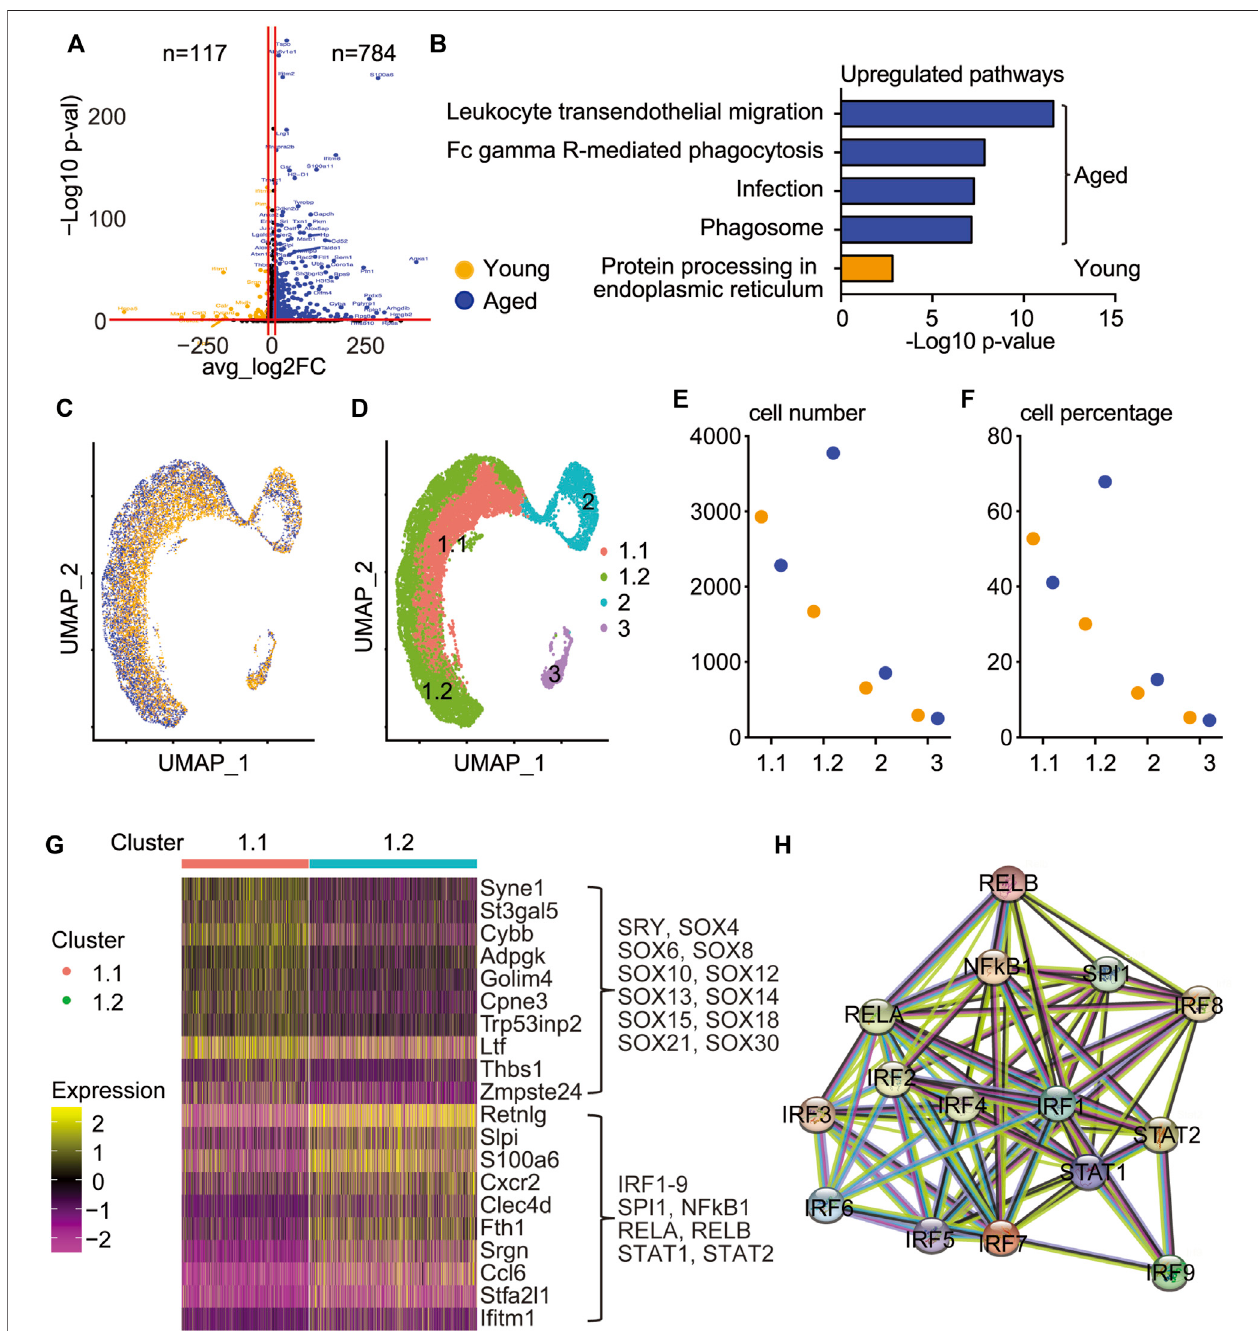
FIGURE 3 | Aged callus SSPCs contain an in fl ammatory osteogenic sub-cluster with upregulated IRF pathway. Bioinformatics analysis of clusters 1 – 3 comparing young and aged SSPCs. (A) Upregulated genes in young and aged SSPCs were demonstrated on the volcano plot, with each dot representing an individual gene. 117 and 784 genes with a log2FC greater than 2 and a p -value less than 0.05 in young and aged samples were colored in orange and blue, respectively. (B) Upregulated pathways in young and aged SSPCs were identi fi ed using the 117 and 784 upregulated genes in young and aged callus. Only one upregulated pathway was identi fi edinyoungcallusSSPCs,whilethetoppathwaysupregulatedinagedcallusSSPCswererelatedtoin fl ammation. (C) UMAPdemonstratedthatthedistributionof youngand aged SSPCs wasseparated incluster 1osteogenic cluster. (D) Cluster1osteogenic cells were sub-clustered into1.1 and 1.2according totheseparationof young and aged. (E,F) The cell number and percentage of cluster 1.1 were higher in young and vice versa for cluster 1.2 and were comparable in clusters 2 and 3. (G) Heatmap showing top 10 DEGs of clusters 1.1 and 1.2 revealing increased genes related to house-keeping and in fl ammation, respectively, which were driven by SOX family and IRF family transcription factors, respectively, identi fi ed by RcisTarget/R analysis. (H) The interaction map between master regulators of cluster 1.2.